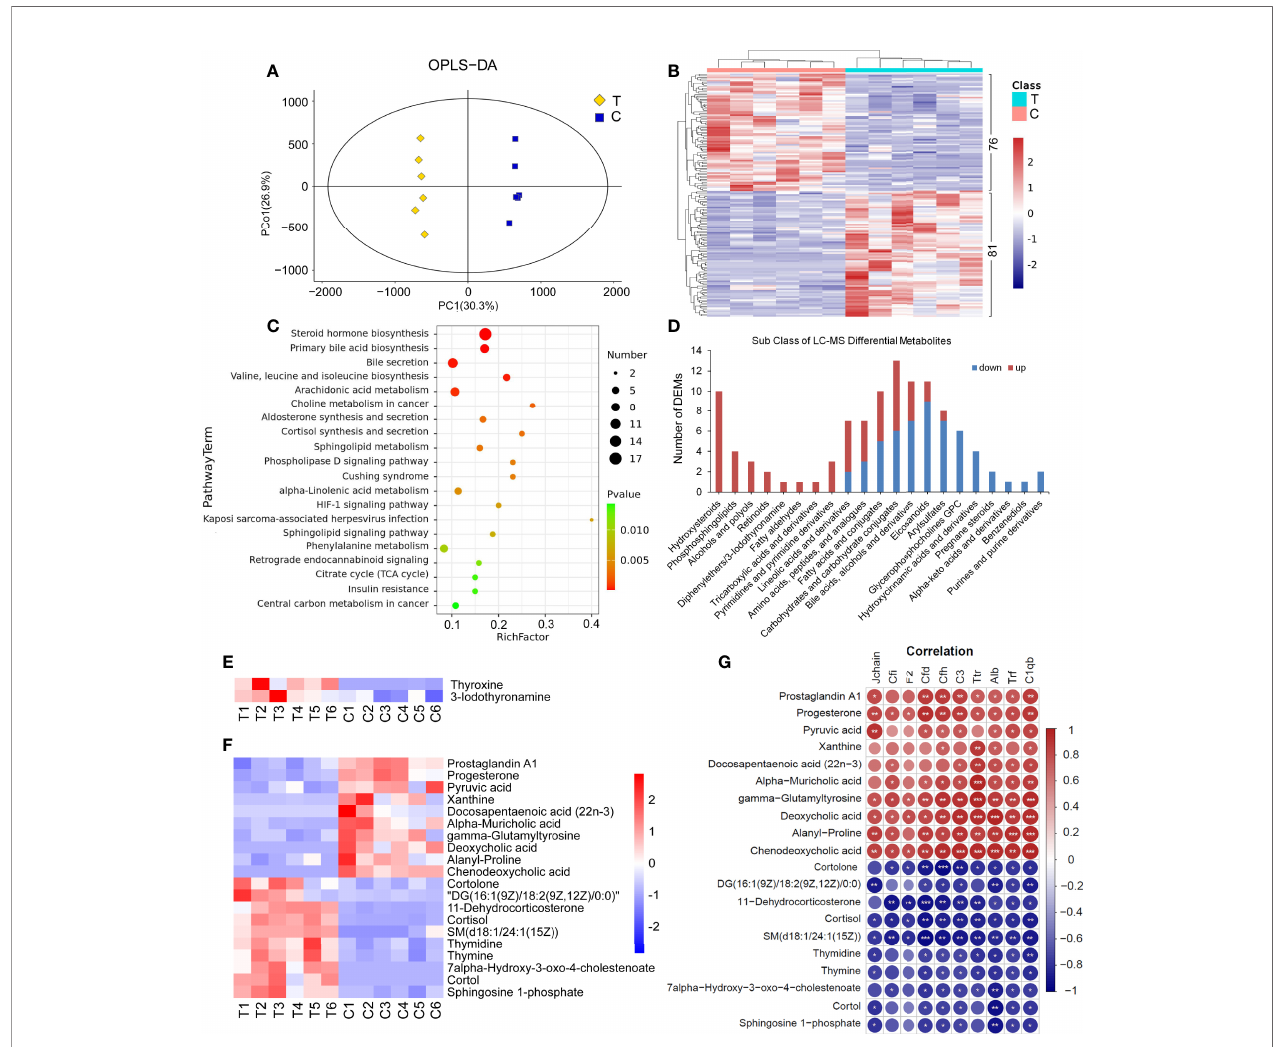
FIGURE 6 | Serum LC-MS metabolomics analysis and the correlation with proteomics. (A) There were signi fi cant differences in OPLS-DA score between the thyrotoxicosis group (T) and the normal control group (C) . OPLS-DA, orthogonal partial least squares discrimination analysis. (B) Clustering heat map of 157 DEMs, including 81 upregulated ones and 76 downregulated ones (HMDB database). (C) The KEGG pathway analysis result of all DEMs. (D) The classi fi cation of LC-MS DEMs. (E) The expression of Thyroxine (T4) and Iodothyronamine (T3) were signi fi cantly upregulated in thyrotoxicosis mice. (F, G) 20 DEMs that were signi fi cantly correlative with Alb and C1qb. Red is positive correlation and blue is negative correlation, correlation signi fi cance: * p <0.05; ** p <0.01; *** p